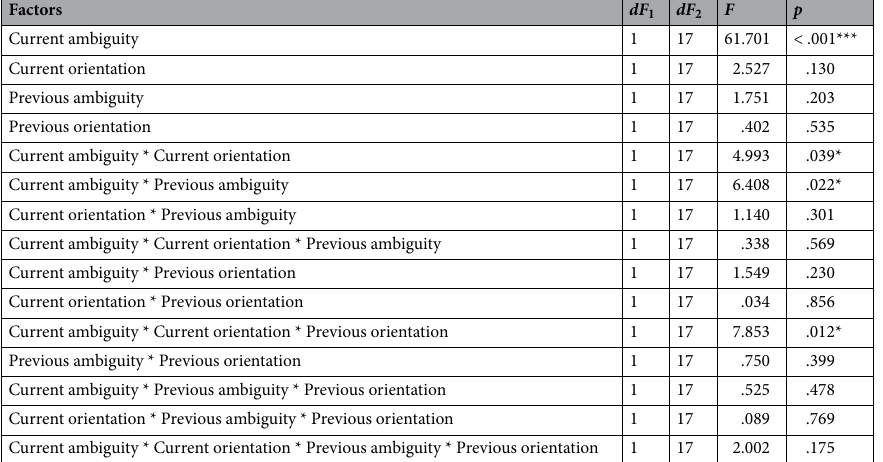
Table 1. Median Response time to the current stimulus, RT [s] (ANOVA Summary).